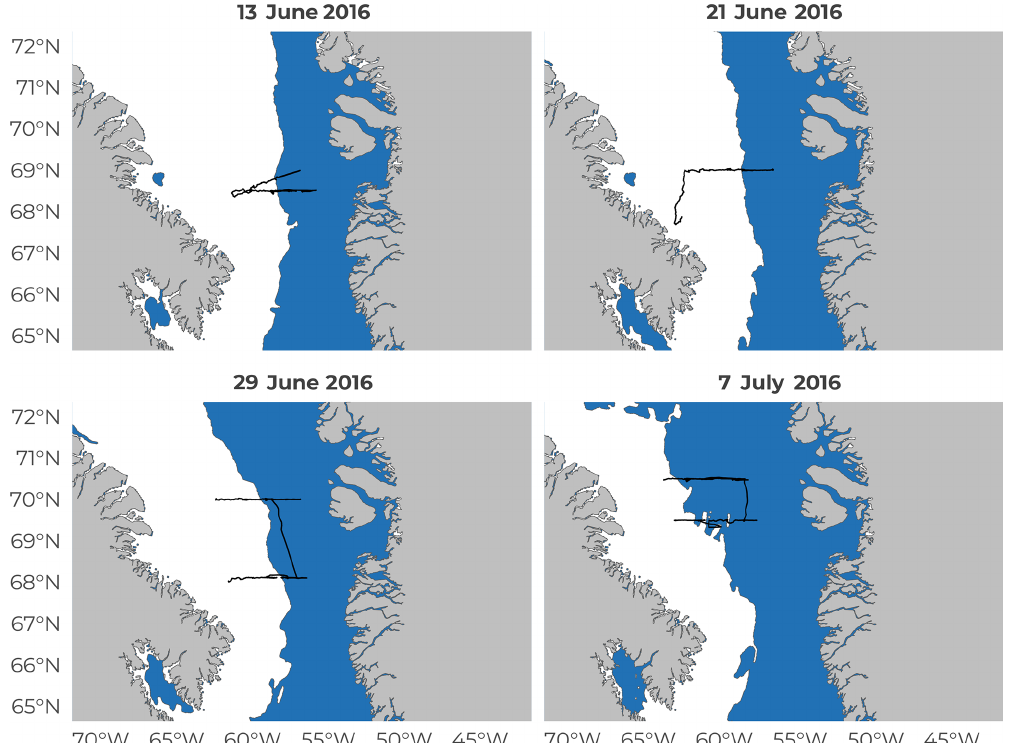
Figure 6. Average weekly sea-ice extent for each of the four 8d periods during the Green Edge cruise. Date is the median date of each 8d sampling period. The white areas represent sea ice and the blue areas the open water. Black lines represent the ship route during said 8d